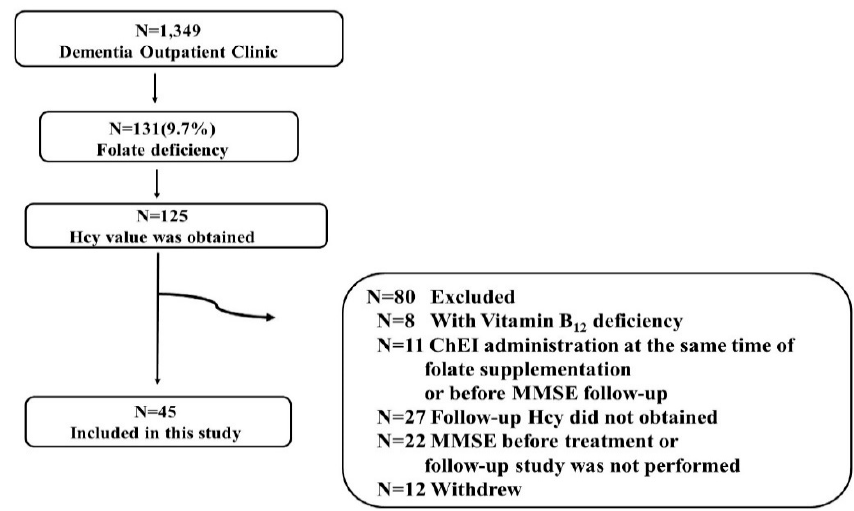
Figure 2. Flow chart detailing the derivation of the study sample. Of such patients, homocysteine (Hcy) was evaluated in 125 patients. Among them, 80 patients were excluded for the reasons described below: accompanying vitamin B 12 deficiency (N = 8), choline esterase inhibitor (ChEI) administration at the same time as folate supplementation or before MMSE follow-up (N = 11), follow-up Hcy did not obtained (N = 27), MMSE before treatment or follow-up study was not performed (N = 22), or withdrew from the study (N = 12). In total, 45 patients were enrolled in this study.